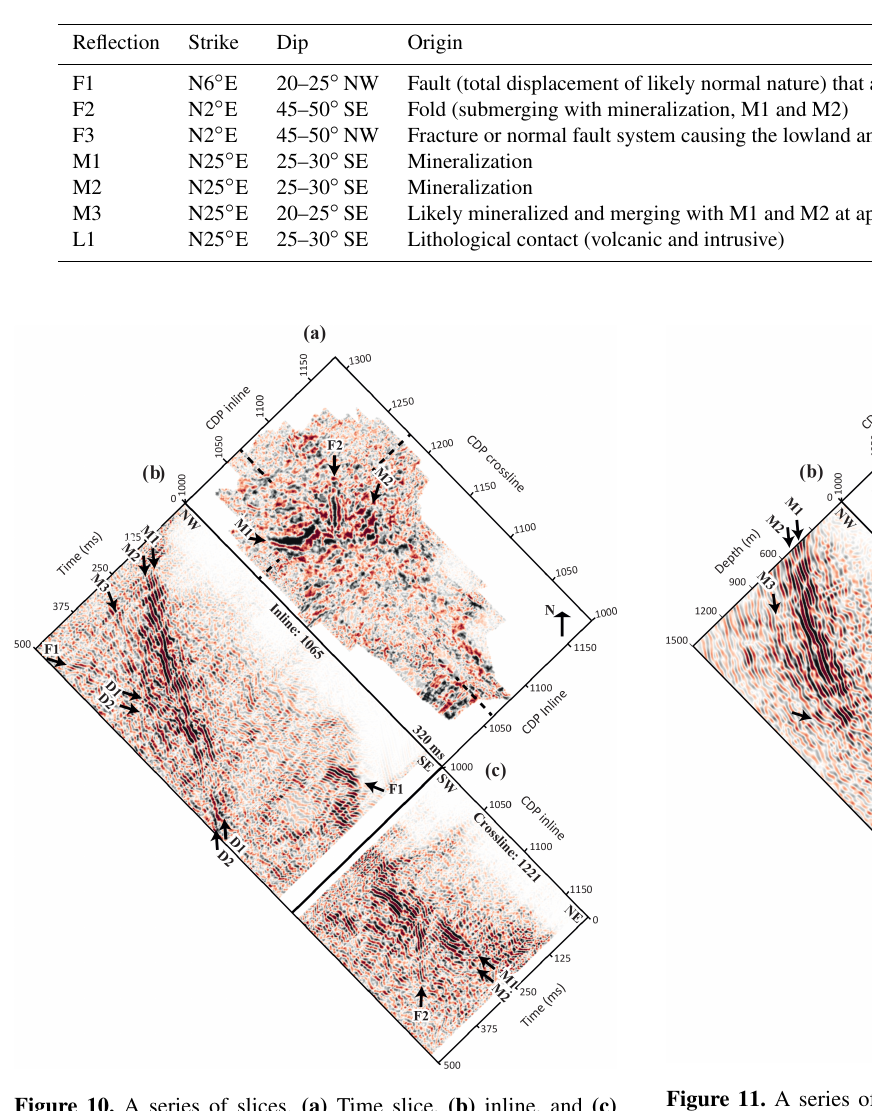
Table 3. Identified main reflections and their 3D geometry.